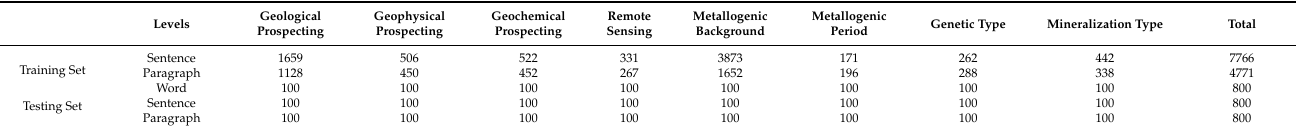
Table 3. Statistics describing the numbers of each category and levels in the training and testing